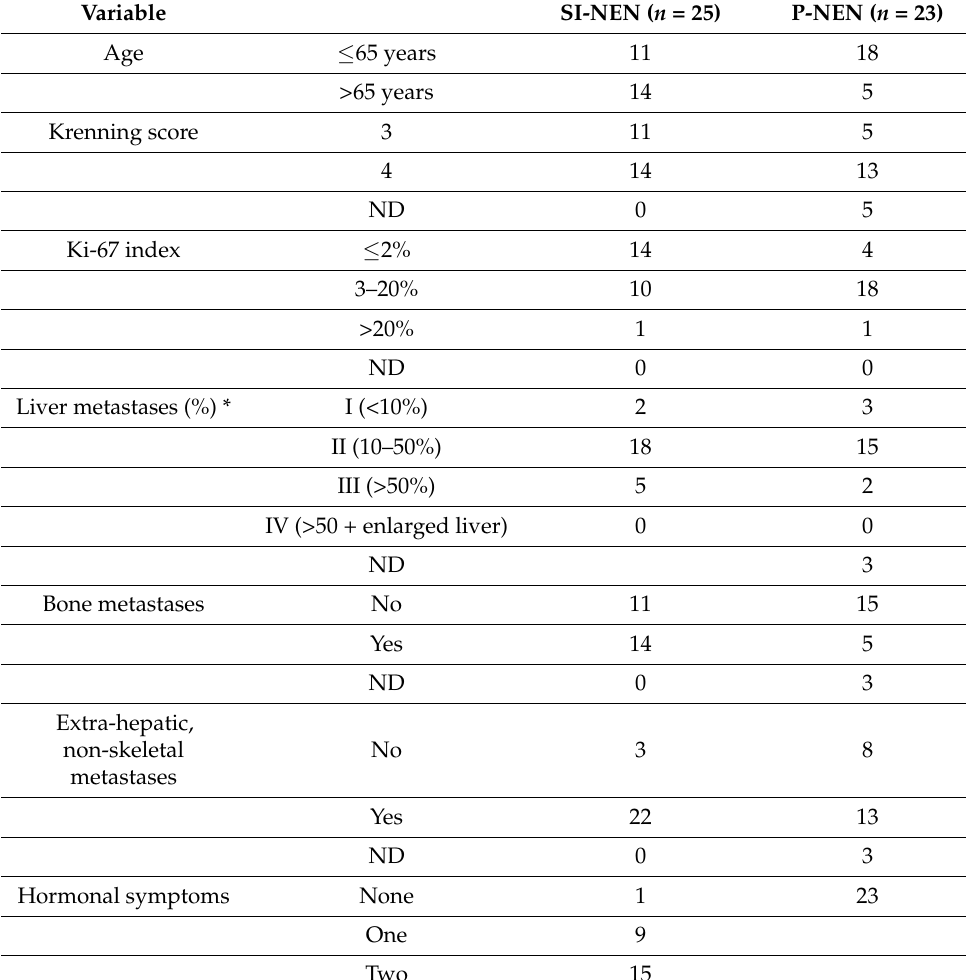
Table 1. Characteristics for the 25 SI-NEN and 23 P-NEN study patients at baseline.